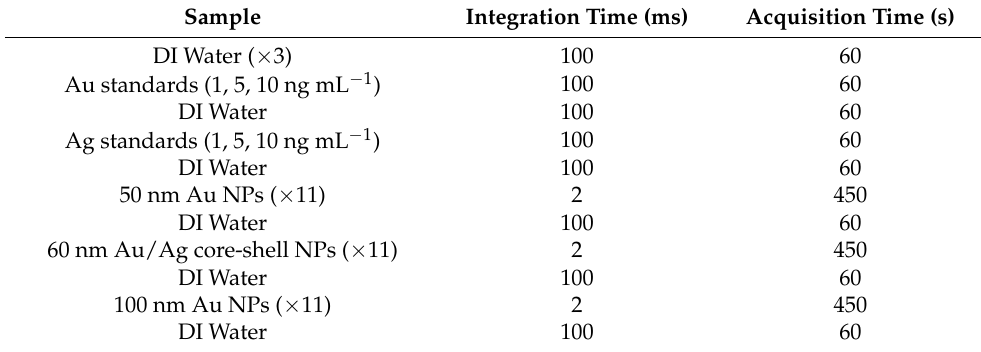
Table 3. Single Particle (SP)-ICP-MS example sequence with respective integration (ms) and acquisi- tion (s)